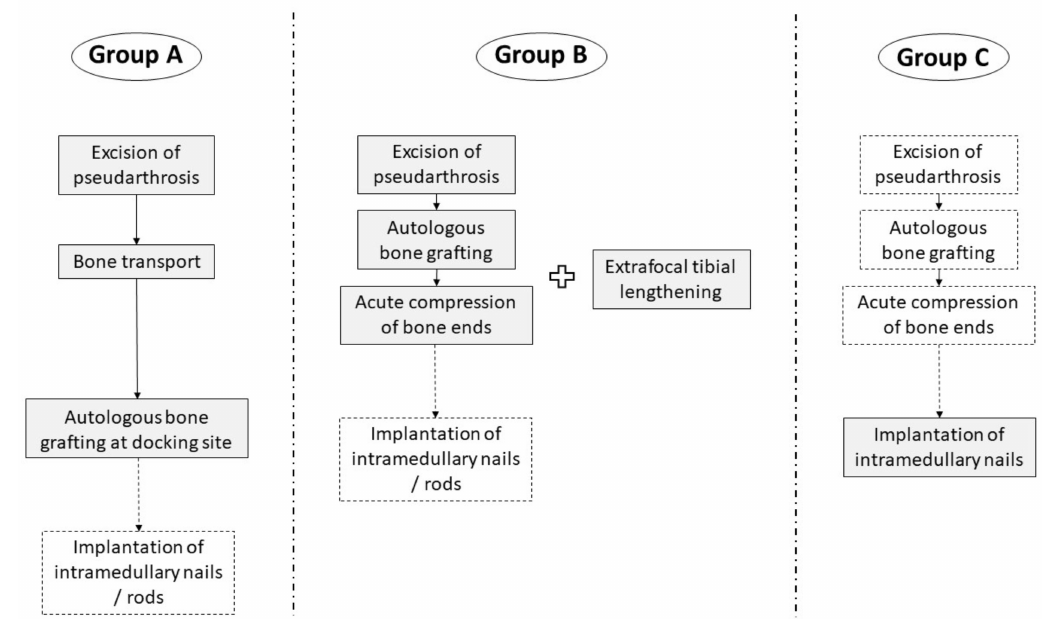
Figure 3. Surgical procedures in the di ff erent study groups. Boxes with dashed lines: procedures were not performed in all